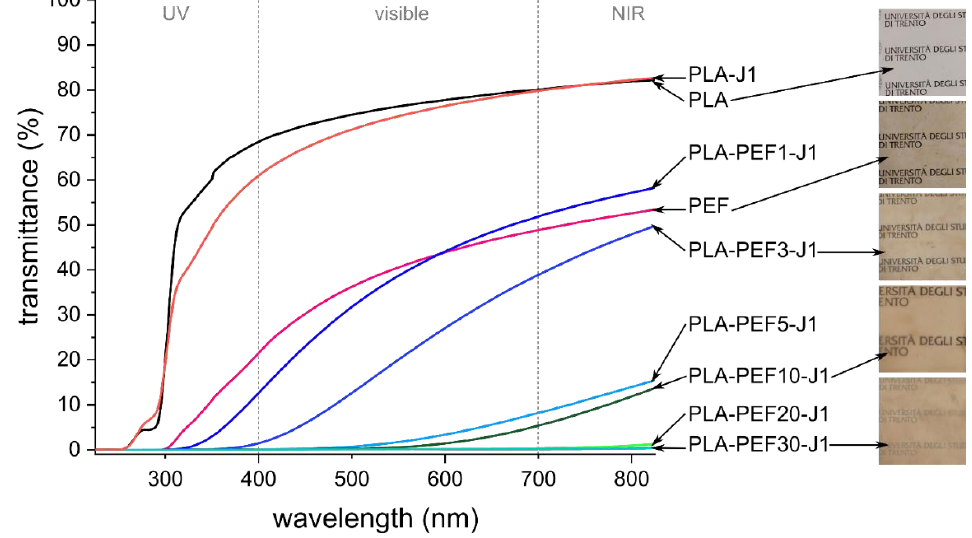
Figure 10. Transmittance spectra of the prepared films with pictures of some selected specimens (square edge = approx. 4 cm).